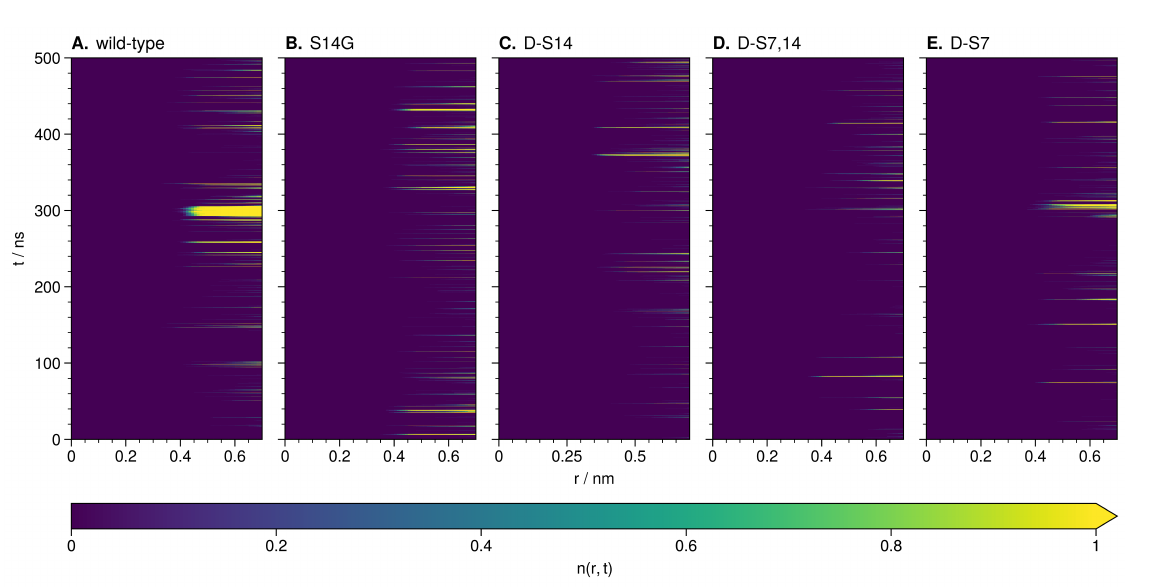
Figure 7. TRRDF for residue 14 during unbiased MD simulations of wild-type ( A ) and mutations ( B – E ) of HN. Increasing brightness indicates a higher n ( r , t ) value (the mean number of sodium ions up to point r